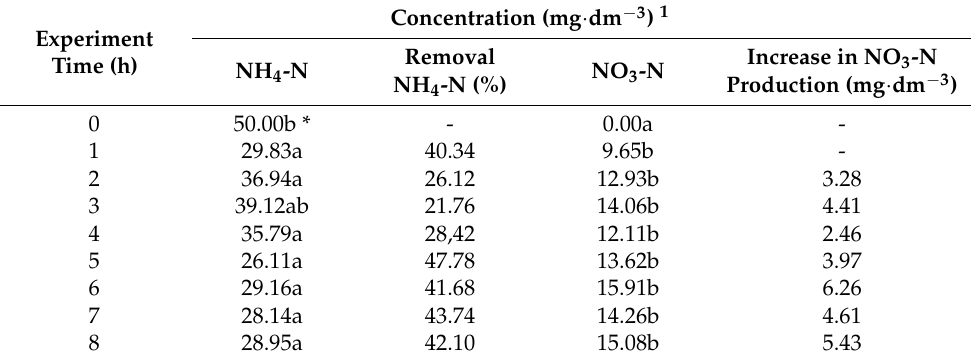
Table 6. The effect of ammonium nitrogen at a concentration of 50 mg · dm − 3 on the activity of nitrifying bacteria—dynamic